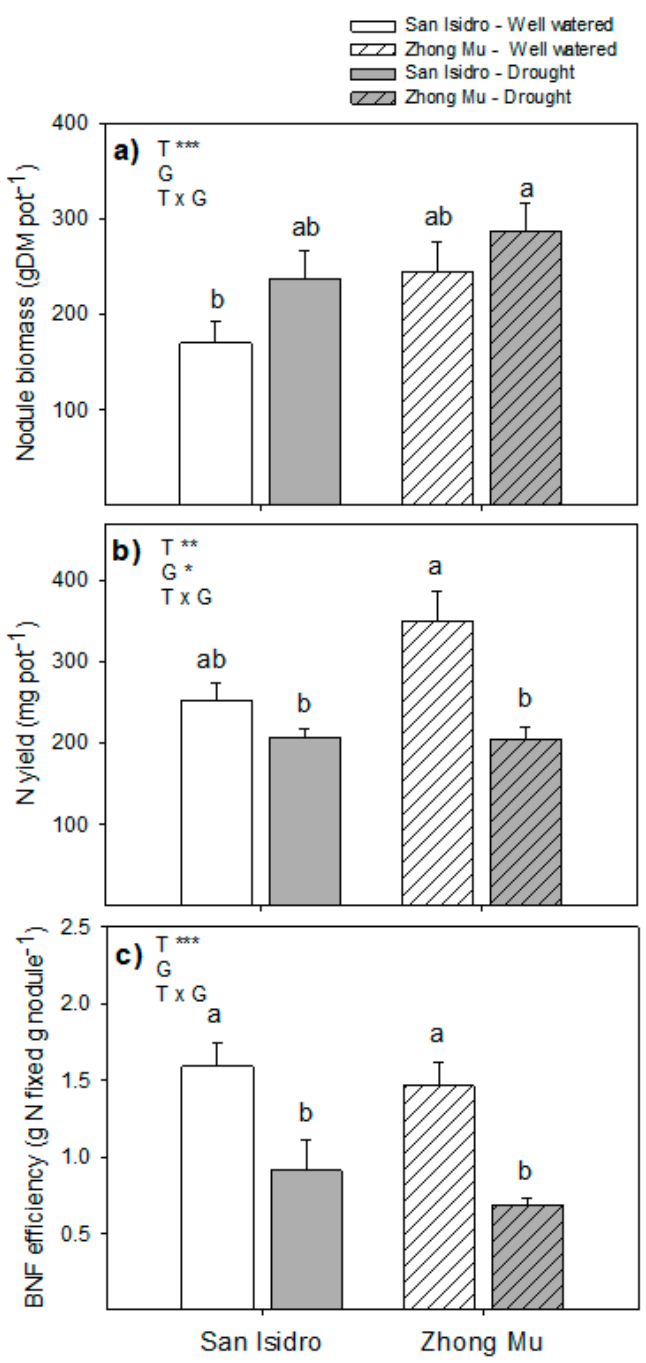
Figure 2. ( a ) Nodule biomass; ( b ) N yield per pot and ( c ) biological nitrogen fixation (BNF) e ffi ciency under control and drought conditions in two cultivars of Medicago sativa : San Isidro and Zhong Mu. Each value represents the mean ± SE ( n = 6). The di ff erent letters indicate significant di ff erences ( p < 0.05). Asterisks indicate significant di ff erences: * p < 0.05, ** p < 0.01, *** p < 0.001, in the two-way ANOVA for water-stress and